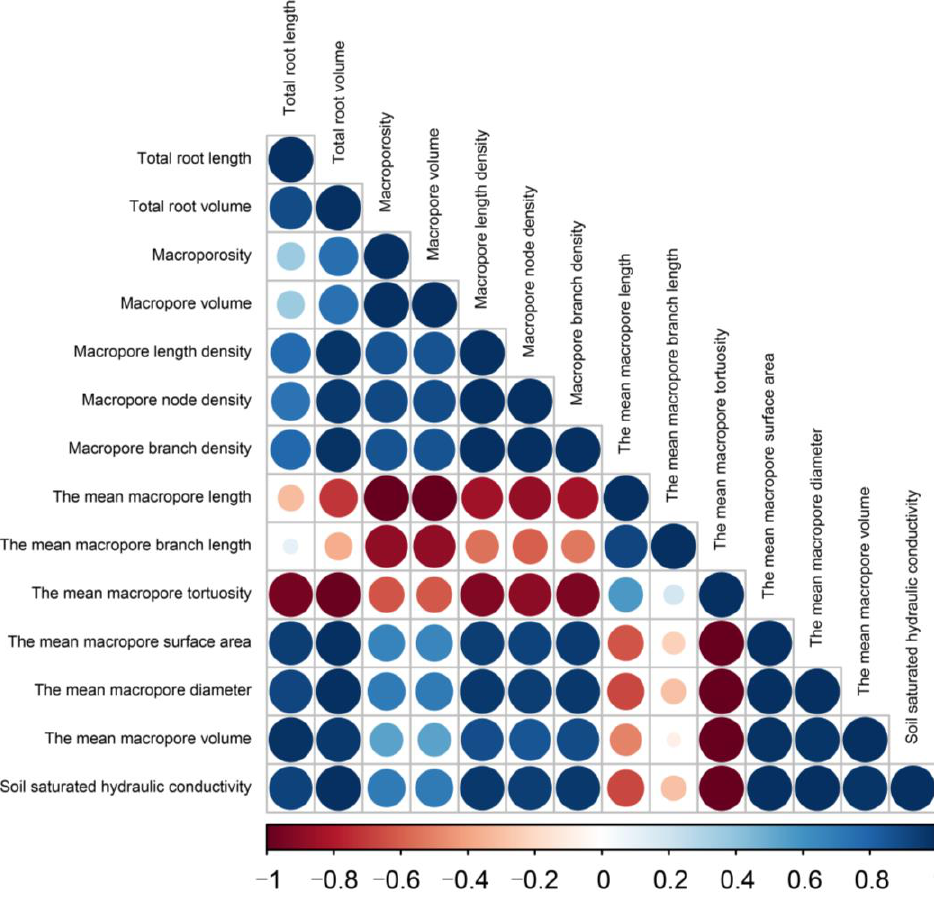
Figure 8. The correlation analyses between root systems, soil macropores, and soil saturated hy- draulic conductivity.